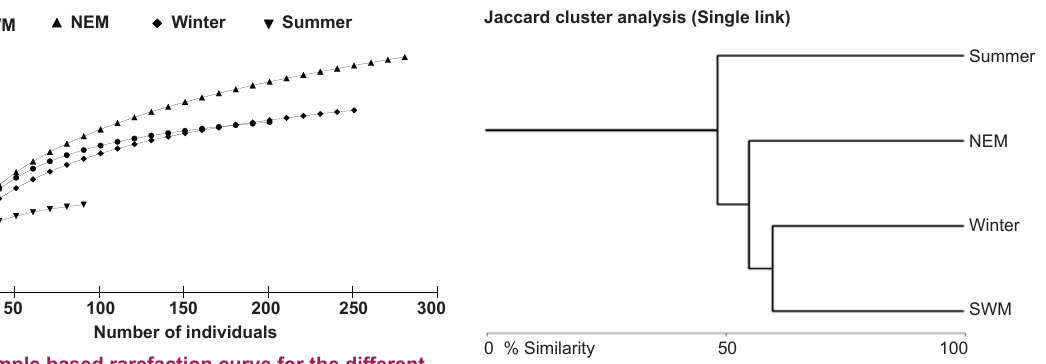
Figure 5. Jaccard similarity matrix dendrogram (presence and absence) comparing different seasons by their butterfly species assemblage the community composition (Fig. 3). Seasonal richness: Estimates of species richness during different seasons are expressed through sample based rarefaction (Fig. 4). Expected number of species have been plotted against occurrence of individuals. This plot provides a measure of species diversity which is robust to sample size effect permitting comparison between communities. Steep curves indicate more diverse communities. A striking point of an examination of the rarefaction curves is that during NEM period highest curvature was noticed indicating more diverse communities which also coincided with field observation. This means that species richness per occurrence of individuals was highest in this season. The other extreme season was summer during which relatively low species richness was observed.